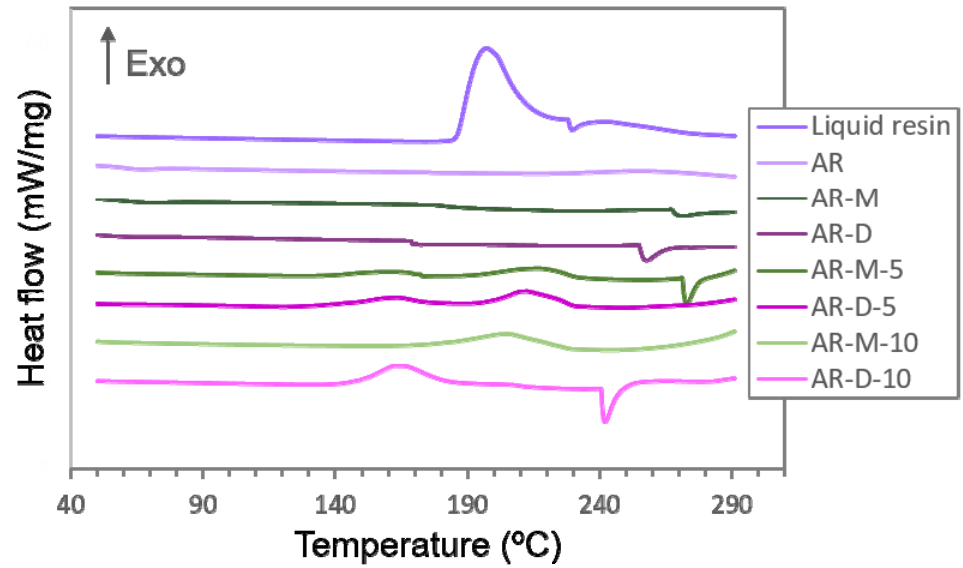
Figure 6. DSC thermograms of the liquid resin and the Ag nanocomposites.